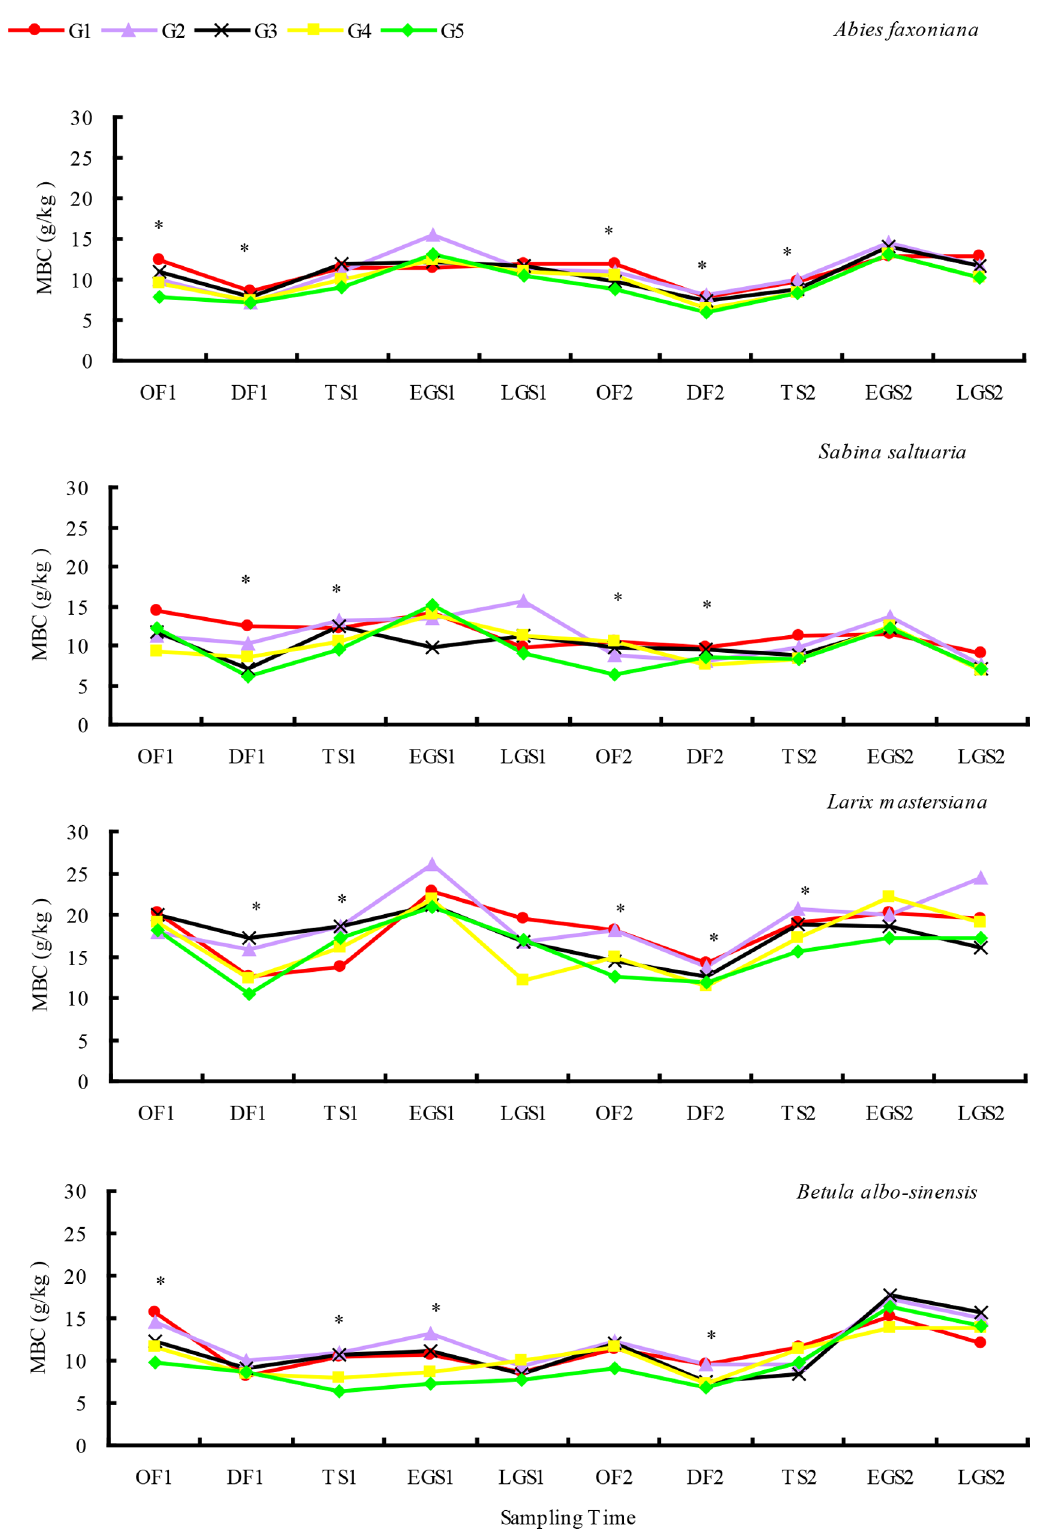
Figure 5. MBC during litter decomposition from gap center to closed canopy at different decomposition stages over 2 years (mean ± SD , n =5). The symbols ‘‘*’’ indicate the significant difference among treatments (LSD’s multiple range test; P , 0.05). Abbreviations: MBC =microbial biomass carbon; OF=onset of freezing stage; DF=deep freezing stage; TS=thawing stage; EGS=early growing season; LGS=late growing season; G1=gap 1, gap center south; G2=gap 2, gap center north; G3=gap 3, canopy edge; G4=gap 4, expanded edge; G5=gap 5, closed canopy.